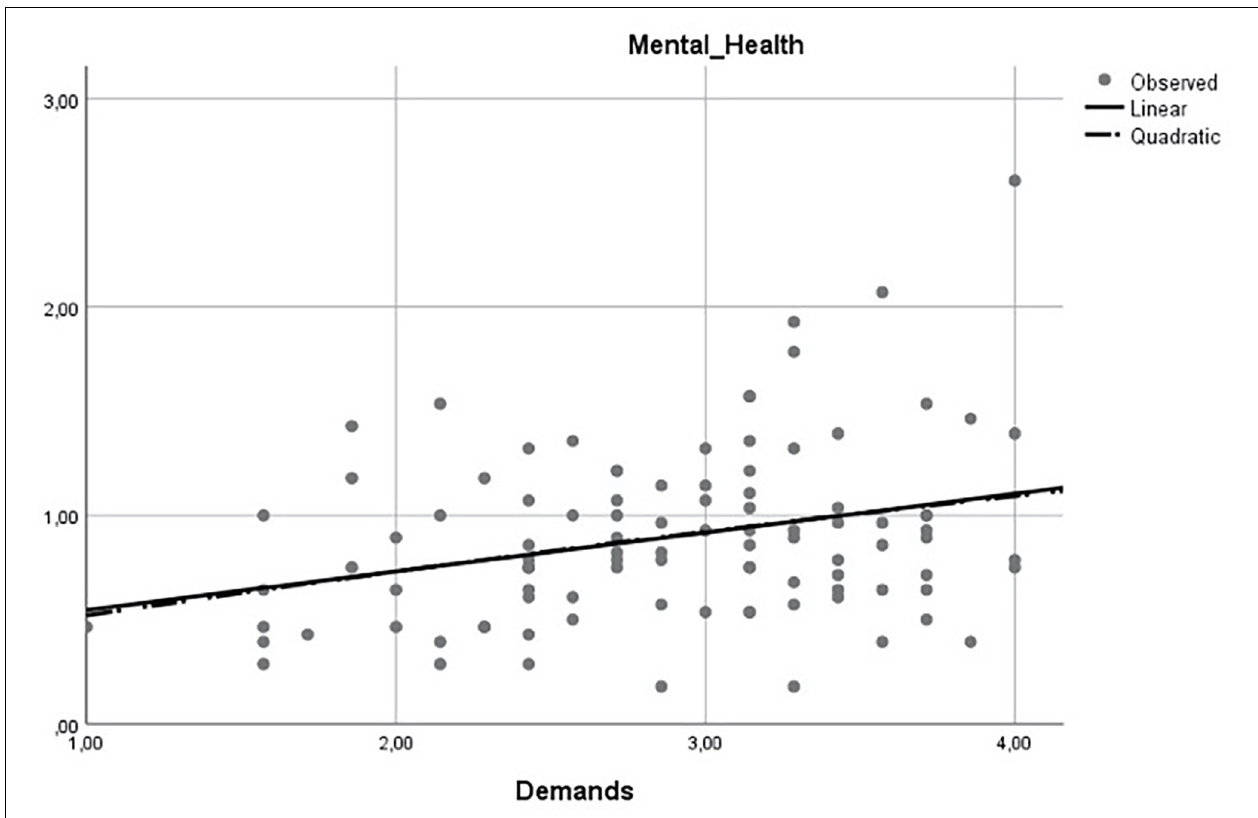
FIGURE 3 | Linear and Curvilinear estimates for men. TABLE 4 | Results for the linear and curvilinear (quadratic) regression models for the relationship between job demands and mental health. Equation